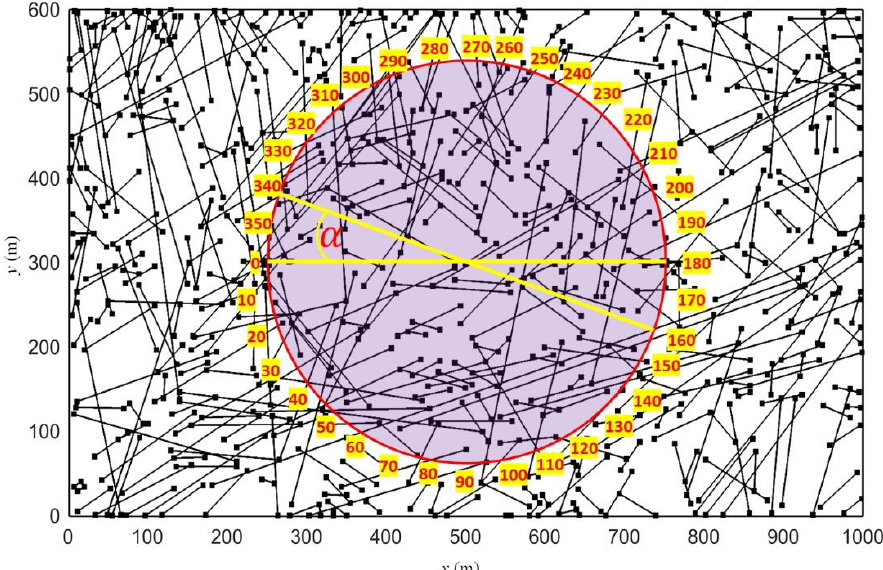
Figure 2. The geometry of the reservoir. Injection and production wells are placed 500 m apart. Total 36 cases or 36 values of α are considered for simulations. Here, when the injection well is present at 0 and production well is present at 180 and they are 500 m placed apart, the value of α is 0. When the injection well is present at 340 and the production well is present at 160, the value of α is 340.